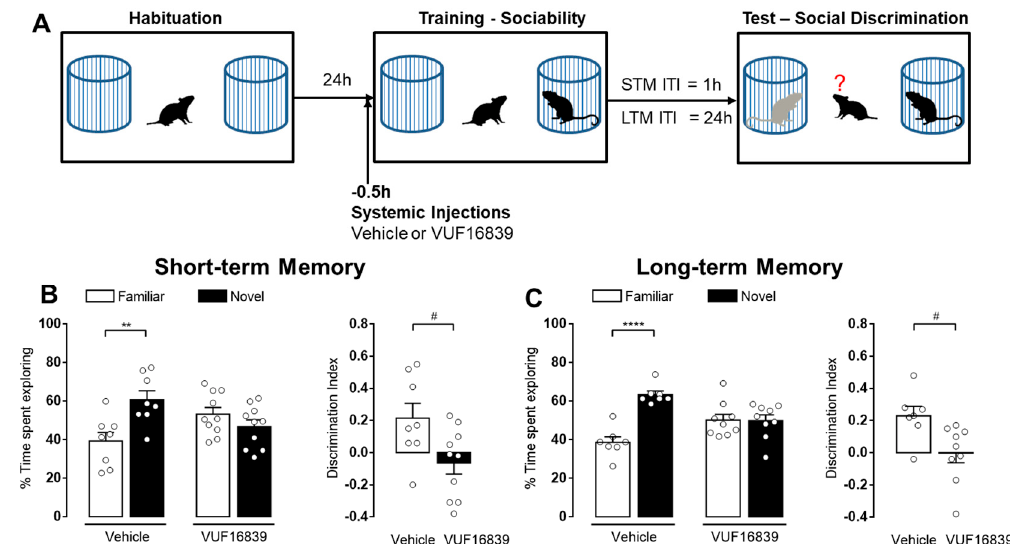
Figure 2. Impact of acute histamine depletion on short- and long-term social recognition memory. ( A ) Schematic drawing showing the sequence of the behavioral procedures. α FMH (5 µg) or vehicle were injected directly into the lateral ventri- cles of Hdc +/+ male mice immediately after habituation. Retention test sessions were performed 1 h ( B ) or 24 h ( C ) after training. Shown are means ± S.E.M. of 7–10 animals per experimental group. **** p < 0.0001, *** p < 0.001, ** p < 0.01 by two- way ANOVA and Bonferroni’s MCT; ### p < 0.001, ## p < 0.01 by unpaired t -test.